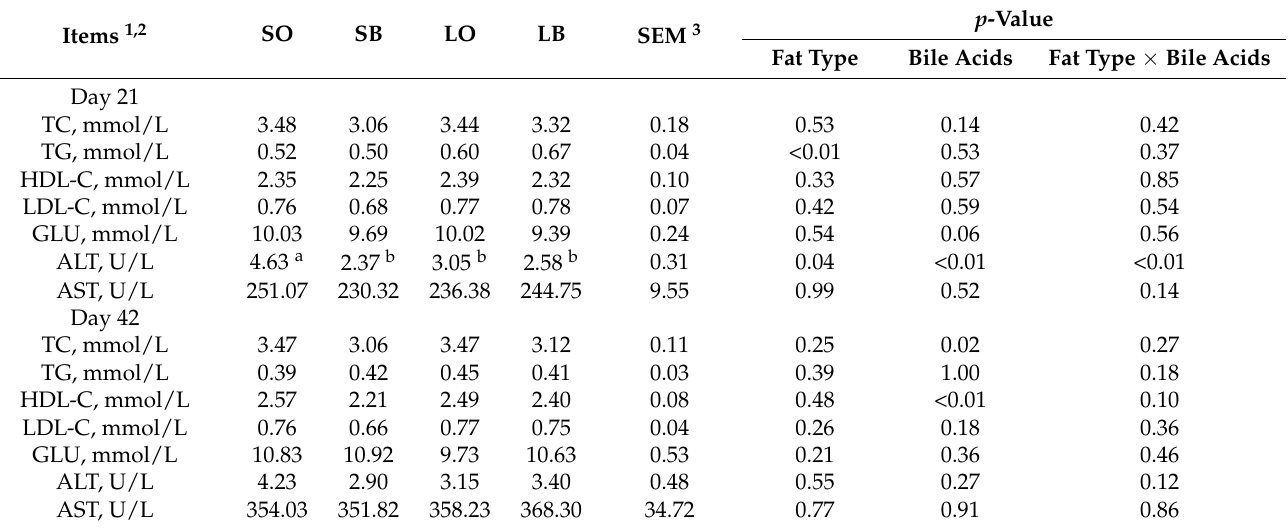
Table 6. Effects of bile acids supplemented in diet included with different types of fat on serum biochemical parameters in broiler